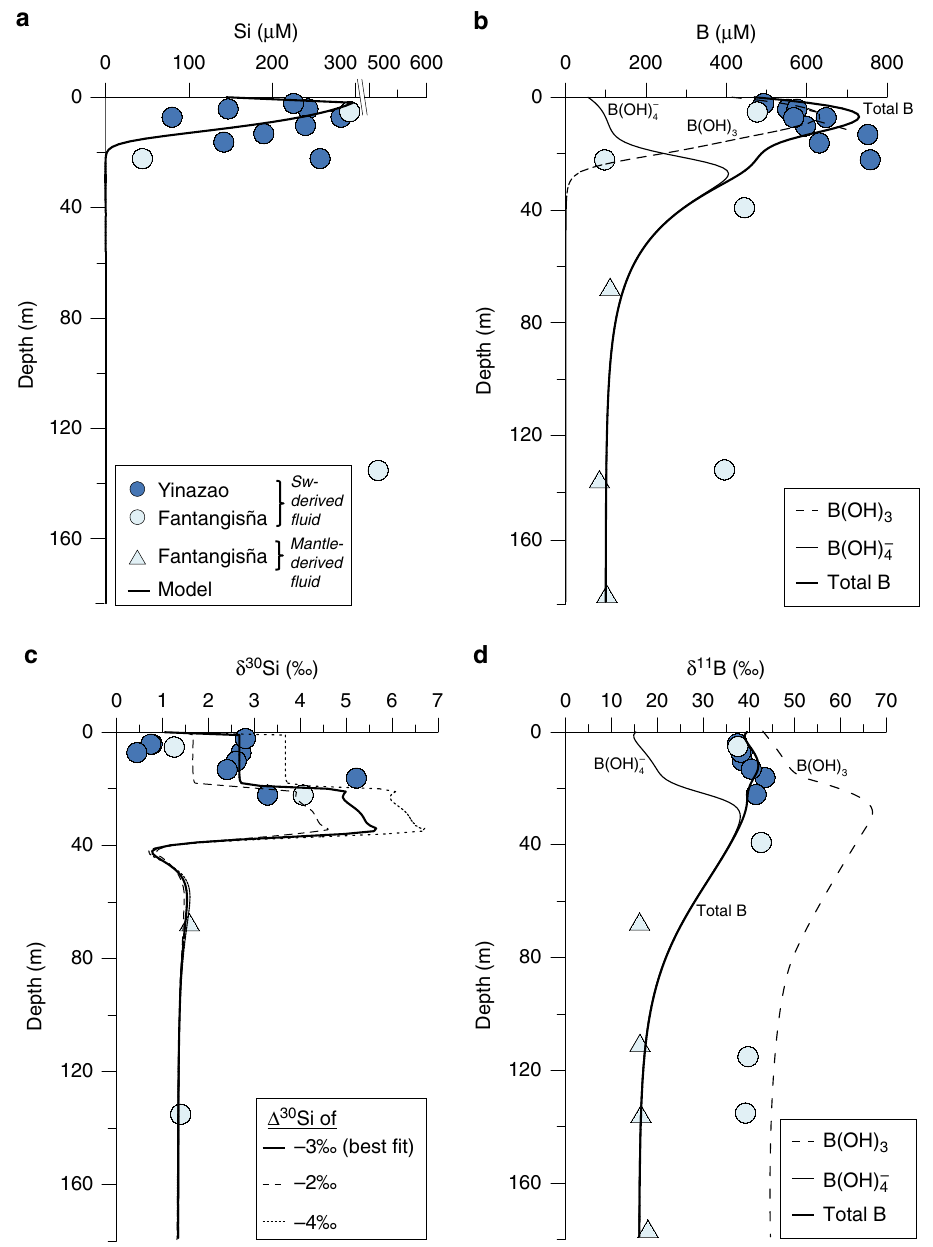
Fig. 6 Depth pro fi les of reactive tracers. a Dissolved Si, ( b ) total dissolved B, dissolved borate (B(OH) 4 − ) and dissolved boric acid (B(OH) 3 ), ( c ) δ 30 Si of dissolved Si. Model data based on a Si isotope fractionation with Δ 30 Si of − 3 ‰ (best fi t) and sensitivity tests assuming − 2 ‰ and − 4 ‰ (dotted lines). d δ 11 B values of total dissolved B, dissolved borate and dissolved boric acid following Zeebe and Wolf-Gladrow 45 and Klochko et al. 46 (see section “ Processes of serpentine alteration ” and Supplementary Methods for details). Error bars (2 SD of individual measurements) within symbol size. Thick or dashed lines indicate steady-state model results (Supplementary